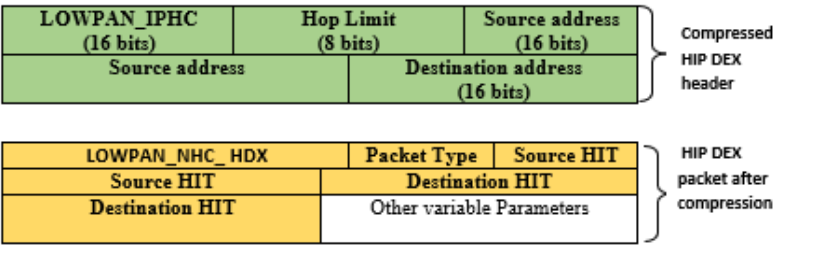
Figure 4. Resulting compressed IPv6/HIP DEX